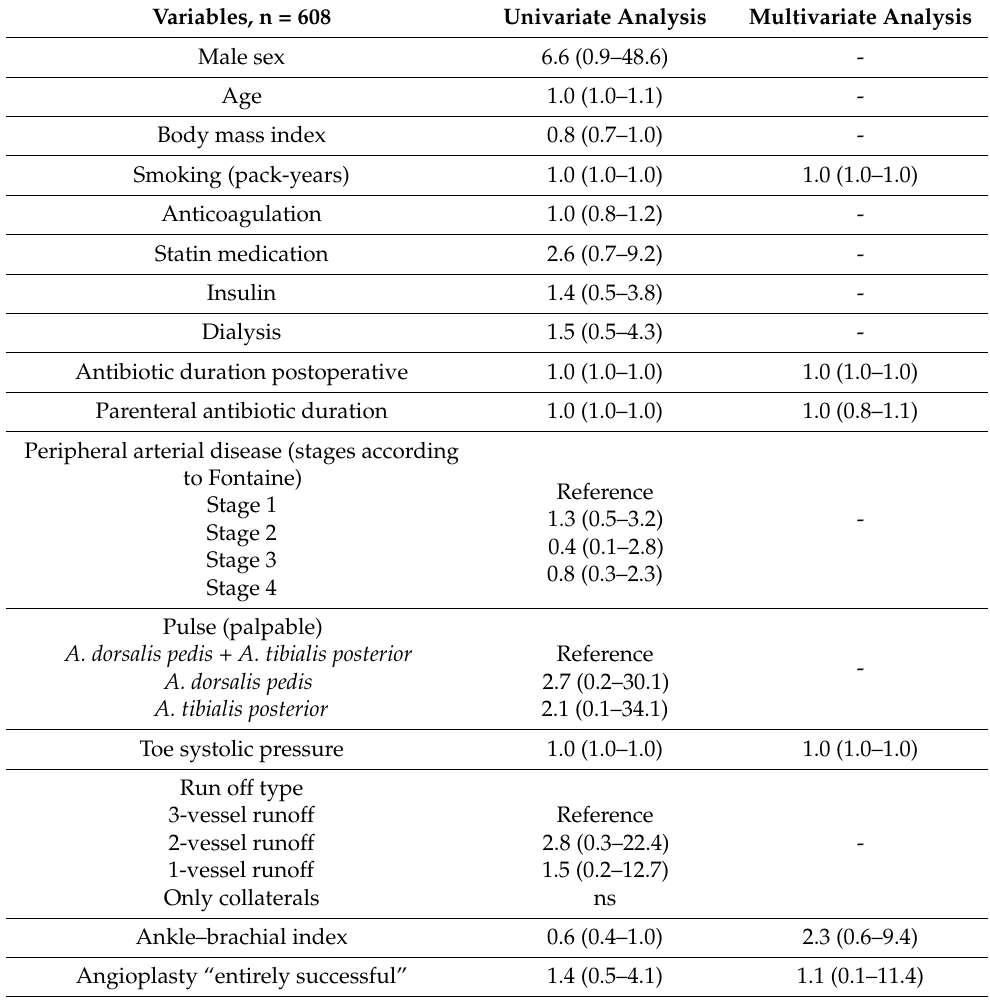
Table 4. Univariate and multivariate analyses of factors potentially associated with the outcome “microbiological failure” (results expressed as hazard ratio with the corresponding 95% confidence interval)